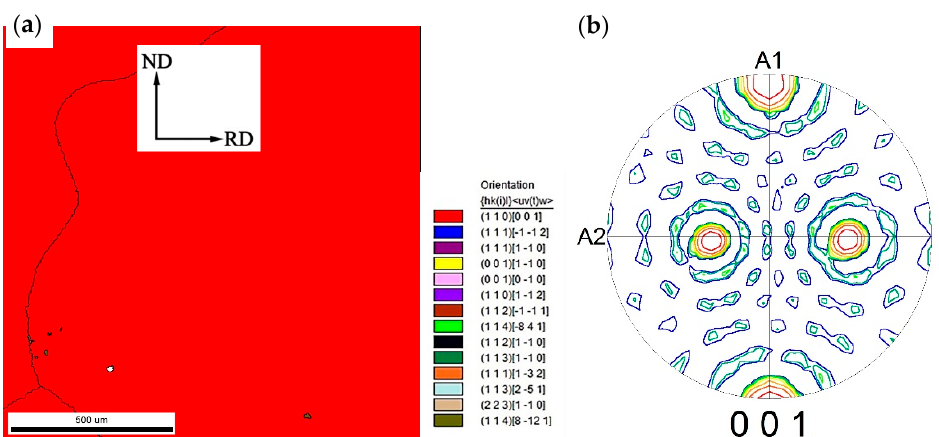
Figure 9. ( a ) Orientation image maps along the thickness direction of secondary cold ‐ rolled sheet annealed, ( b ) {001} polar diagram of secondary cold ‐ rolled plate annealed. Table 1. Magnetic properties of final